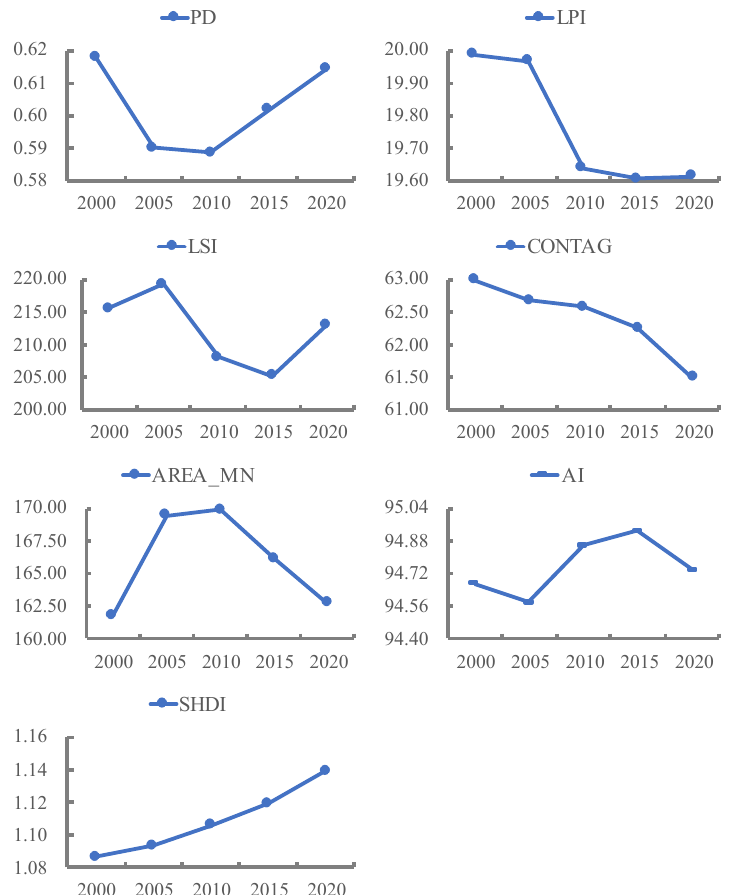
Figure 3. Index change of landscape pattern at the landscape level. The changes in the landscape pattern of land use types can be well explained at the landscape class level. The changes in land use types at the landscape class level in the TGRA in the last 20 years are shown in Figure 4. From 2000 to 2020, the area of cultivated land decreased, the PD, LPI, LSI, and AI of cultivated land decreased, and the AREA_MN increased, showing that the cultivated land patches were divided, the number of dominant cultivated land patches decreased, and the agglomeration decreased. The LPI, AREA_MN, and AI of forestland were the largest in the last 20 years, indicating that forestland is the dominant landscape in the reservoir area with high spatial aggregation among patches. Grassland shows a decreasing trend in all landscape pattern indices except PD, where LPI, AREA_MN, and LSI are significantly decreasing, indicating that grassland fragmentation is increasing, landscape dominance is decreasing, aggregation is weakening, and larger patches are divided. The overall development of the water area is good, and the patch area has increased, AREA_MN, LSI, and LPI have increased by 39.46, 10.2, and 0.49, respectively. With the rapid expansion of construction land, each landscape pattern index of construction land has continued to rise, among which AREA_MN and LSI have increased by 30.37 and 15.49 respectively in the past 20 years, indicating that with the accelerated development of urbanization construction, the built-up area continues to grow, becoming more and more aggregated and highly connected, and the spatial pattern changes. The area of unused land continues to decrease, and its PD, AI, LSP, and other landscape indices all show a certain degree of decline, and the landscape patches become more dispersed and the degree of aggregation gradually